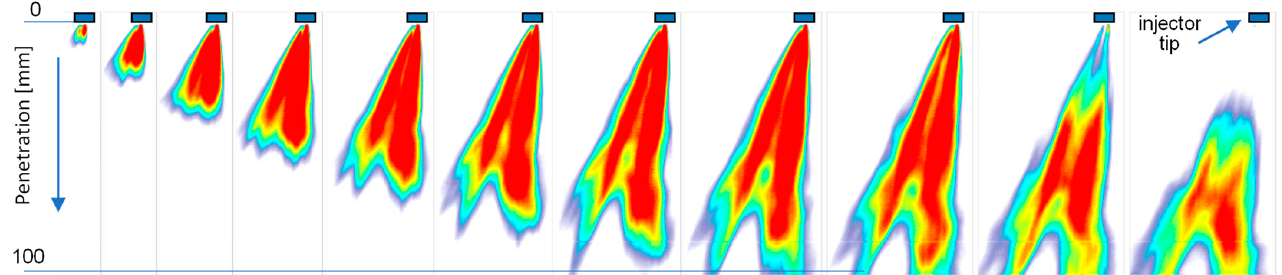
Figure 7. Sequence of fuel spray formation images filmed at 10 kHz ( ∆ t = 100 μ s) in a constant volume chamber (example fuel spray pattern—maximum penetration S = 102 mm).